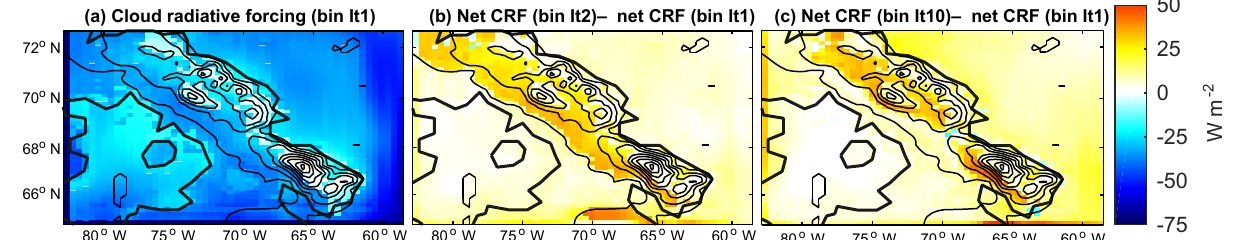
Figure 7. The summer cloud radiative forcing (CRF) in select iterations: (a) the CRF in the Iteration 1 WRF run. Differences in CRF between Iteration 1 and the (b) second and (c) last